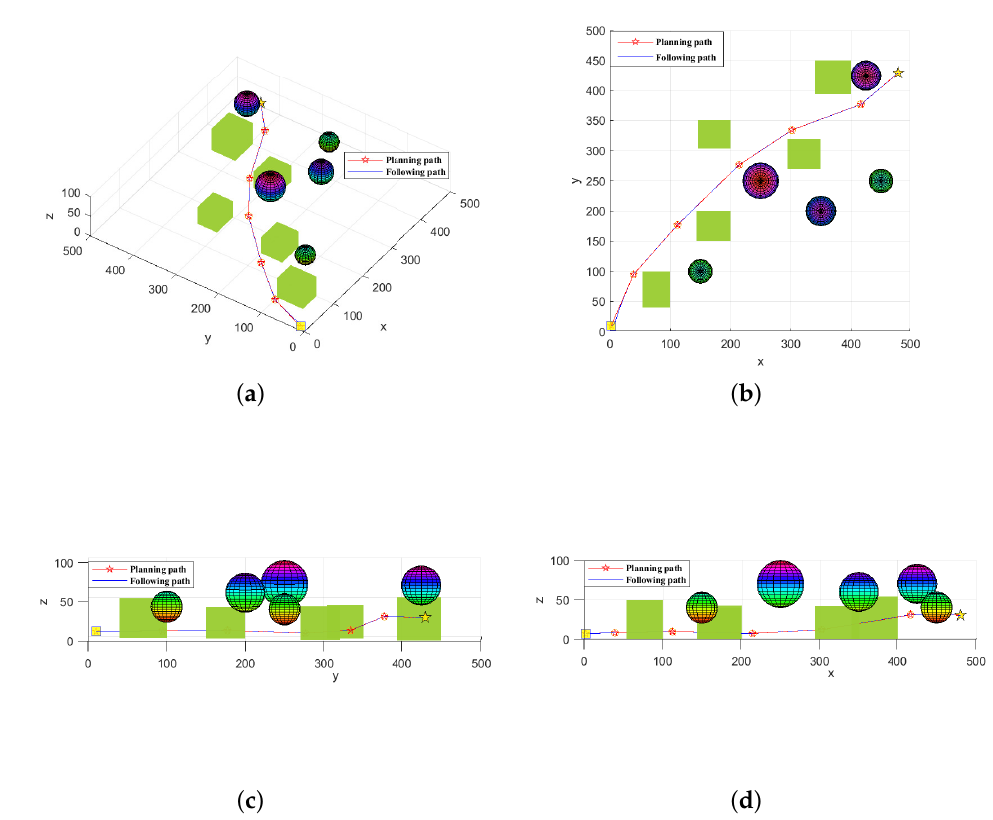
Figure 6. ( a ) The following optimal path in the 3D space 1. ( b ) The following optimal path in the xy plane. ( c ) The following optimal path in the yz plane. ( d ) The following optimal path in the xz plane.